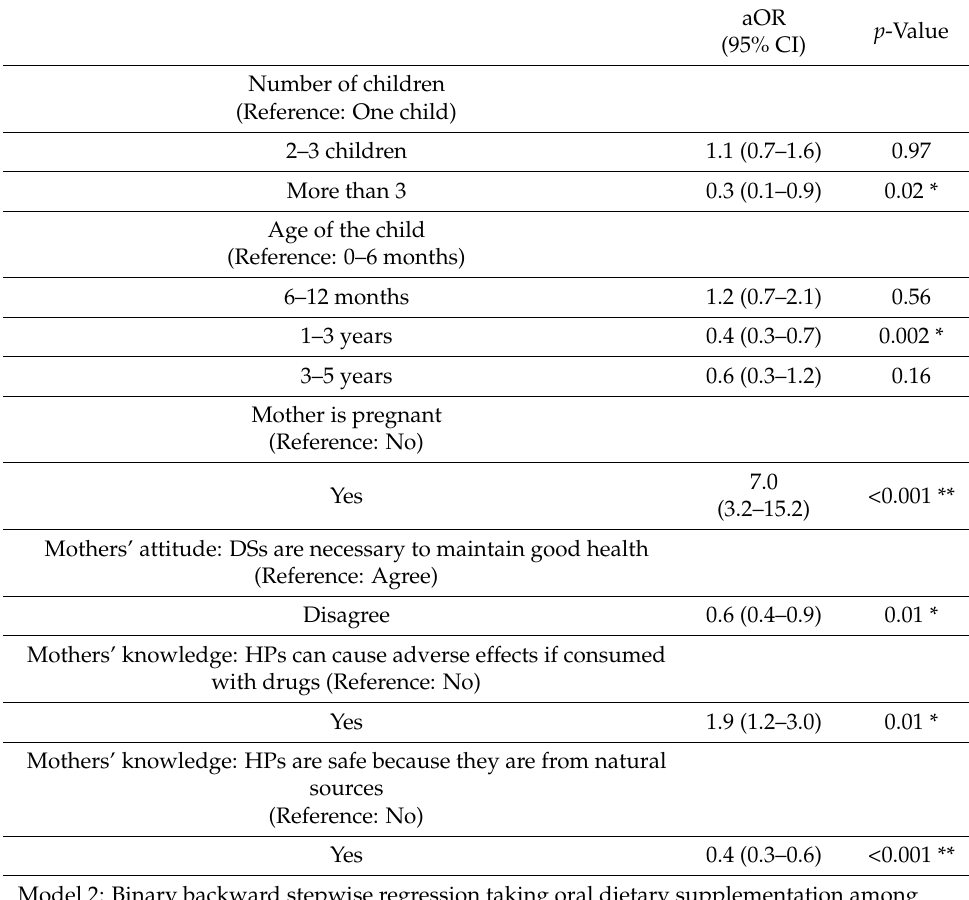
Table 6. Correlates of oral dietary supplementation among mothers and their under-5 children in this study: Regression analysis. Model 1: Binary Backward Stepwise Regression Taking Oral Dietary Supplementation